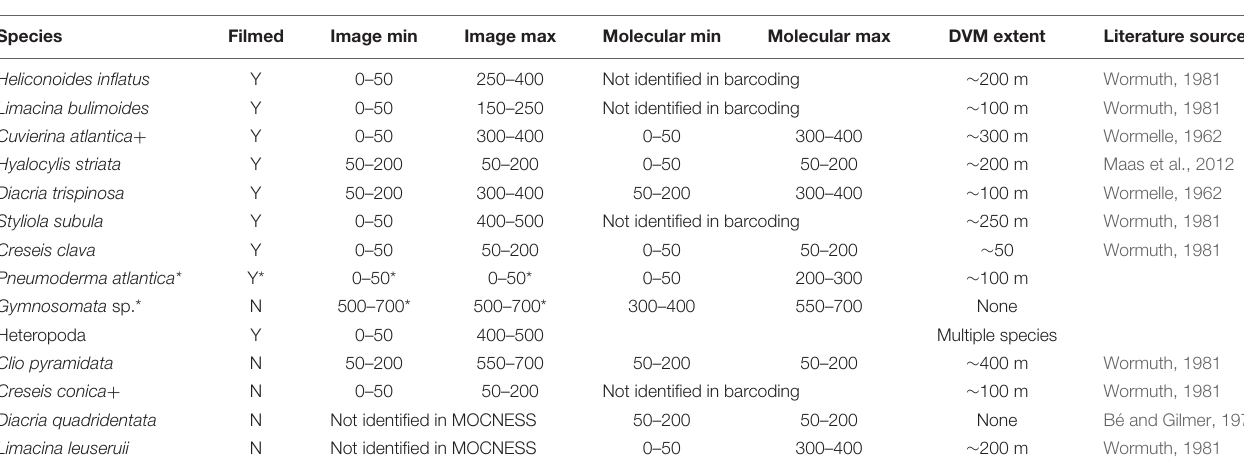
FIGURE 11 | (A) Upward and (B) downward migration times over a distance of 100 m for various marine snail species, based on the mean swimming and sinking speeds measured here. TABLE 3 | MOCNESS distributions of species used in this